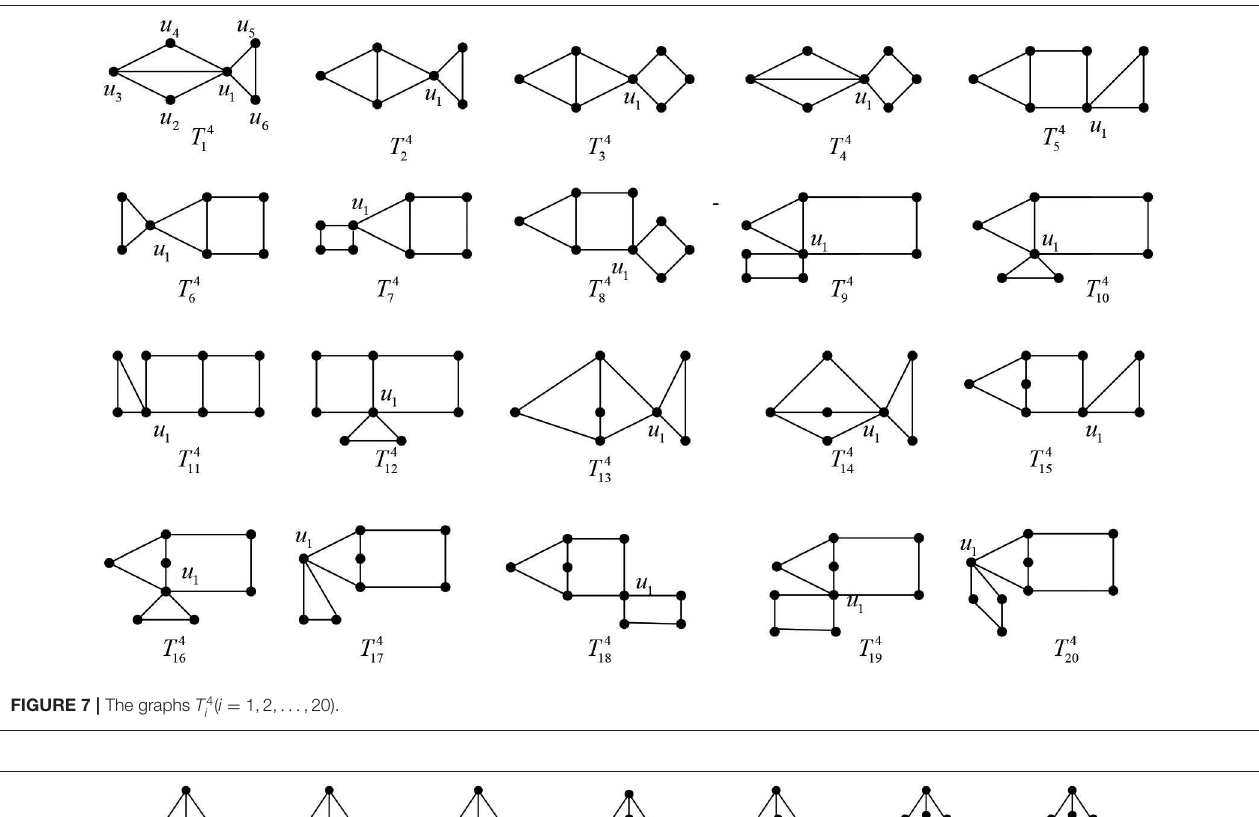
FIGURE 7 | The graphs T 4 i ( i